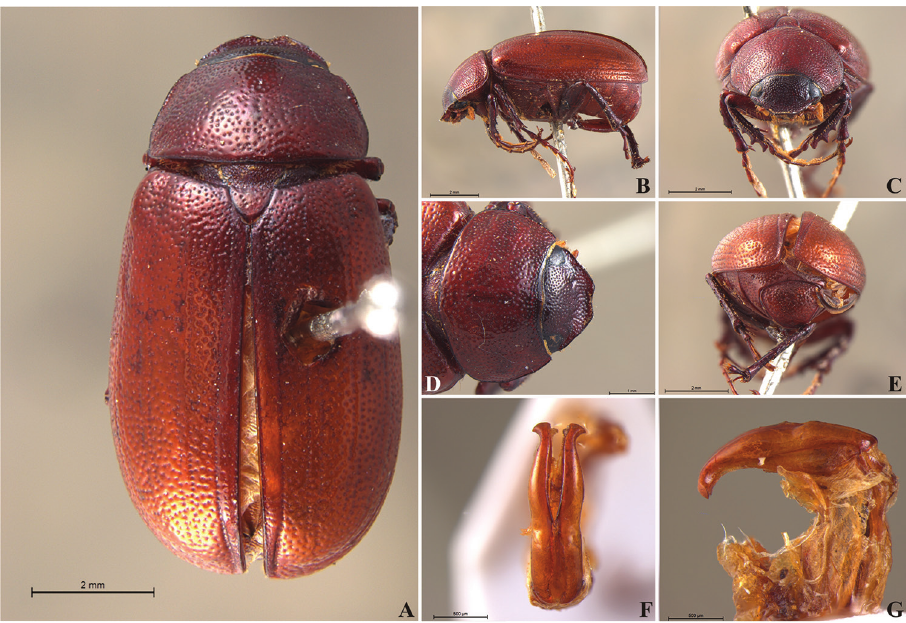
Figure 78. Liogenys unicolor Evans. A Dorsal view B Lateral view C Frontal view D Clypeus and pronotum E Pygidium F Parameres, dorsal view G Parameres, lateral